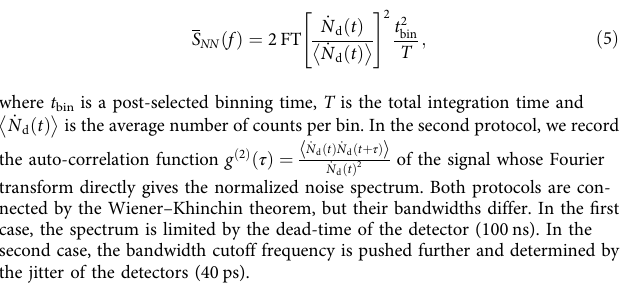
Fig. 5 QD noise spectrum for two different QDs. The shot noise has been (cid:6) ¼ S (cid:2) S shot subtracted: S . QD1 corresponds to the QD studied in the NN NN NN main paper. QD2 belongs to the same nanowire and its noise spectrum is recorded under similar conditions: Ω R ’ γ , Δ = Γ , integration time of sp